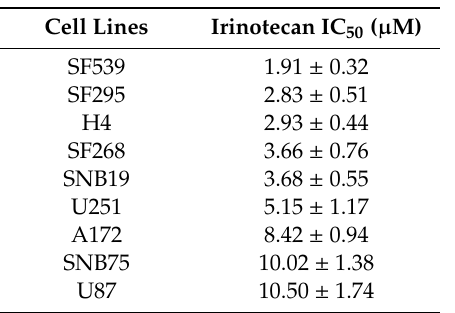
Figure 2. TOP1 and TDP1 protein levels in glioblastoma (GBM) cell lines. Relative levels of ( A ) TOP1 and ( B ) TDP1 protein expression in GBM cell lines were compared by Western blotting against normal human astrocyte (NHA). The signal from actin was used to control the loading of whole cell extract (WCE) proteins (10 µg). Normalized intensity ratios are given for each band, with the intensity ratio of NHA set as 1. The bar graphs show the average and standard deviation as the error bar of measurements from at least three technical replicates in one representative experiment. Whole blots with molecular weight markers are shown in Figure S1. Table 1. Glioblastoma cell lines sensitivities to irinotecan